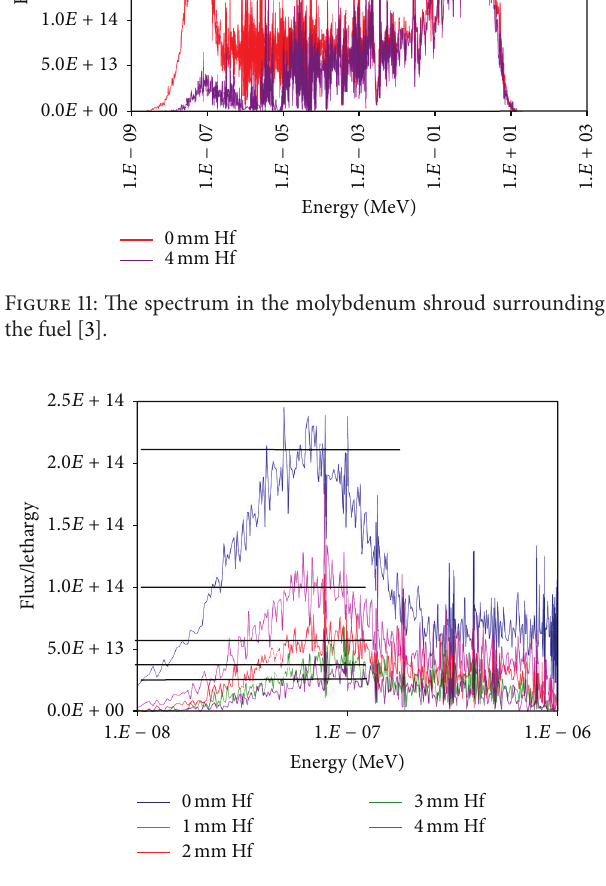
Figure 12: The spectrum in the molybdenum shroud surrounding the fuel. Detail of the thermal energy range for five Hf thicknesses. The horizontal lines mark the height of the thermal peak